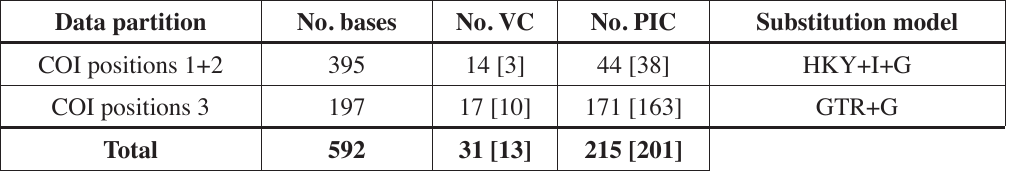
Table 2. Data partitions and selected substitution models. Data subsets used in phylogenetic analyses and their characteristics. VC = variable characters; PIC = parsimony informative characters; [ ] = ingroup only. The partitioning scheme and the respective substitution models were chosen under the AIC with the software PartitionFinder (Lanfear et al.